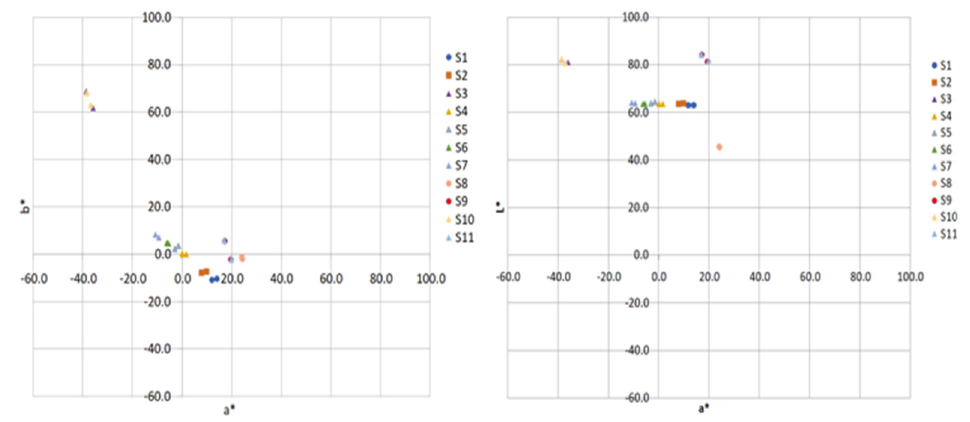
Figure 1. Distribution of 11 sample pairs on the a*b* plane ( left ) and L*a* ( right ) plane under standard D65/2°.